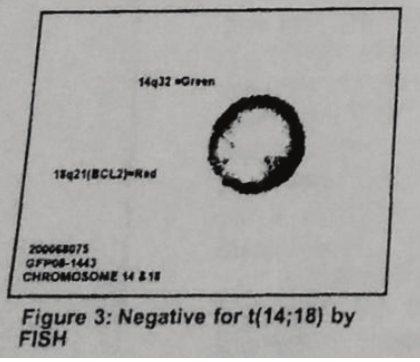
Figure 3: FISH, negative for t(14;18) (bone marrow biopsy